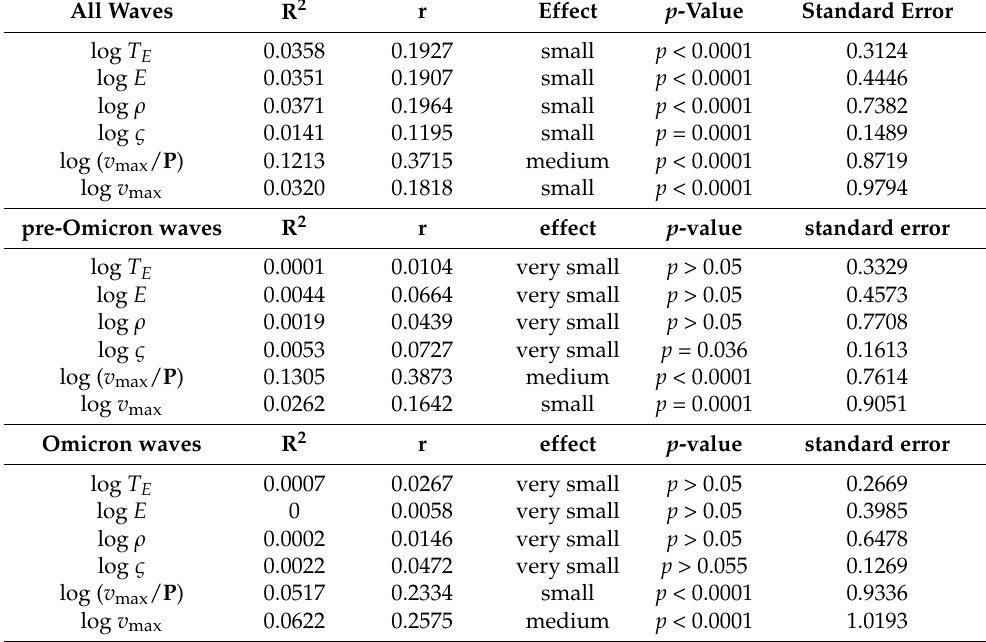
Table 1. Statistical details of Figures 6 and 7; R 2 = coefficient of determination, r = effect size (Cohen’s f); p = probability value; T E = duration of the effective phase; E = effectiveness (of wave management); ρ = E / T E ; log ς = wave shape factor; v max = peak velocity; v max / P = peak velocity per population P